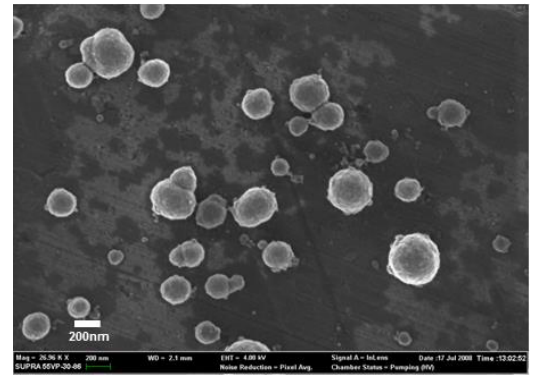
Figure 4. FESEM images of ( a ) drug-free; and ( b ) AmB-loaded solid lipid